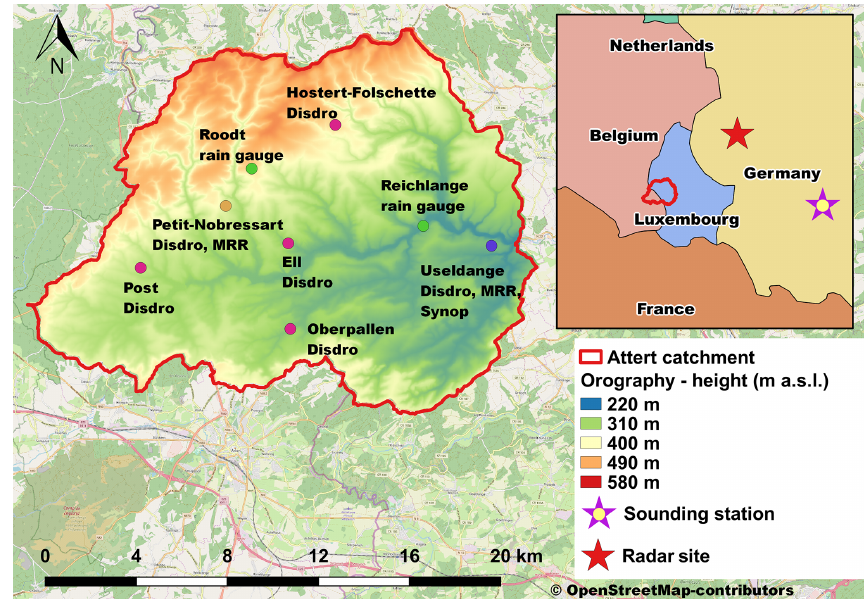
Figure 2. The position of the Attert catchment in Luxembourg and Belgium with superimposed orography (in ma.s.l.) and the locations of the MRR’s, disdrometers, rain gauges, the synoptic station (ASTA) and radar site (Neuheilenbach), and the rawinsonde launching (sounding) station (Idar-Oberstein – WMO-ID 10618) as well as the scale and orientation of the small-scale map. © OpenStreetMap contributors 2019. Distributed under a Creative Commons BY-SA